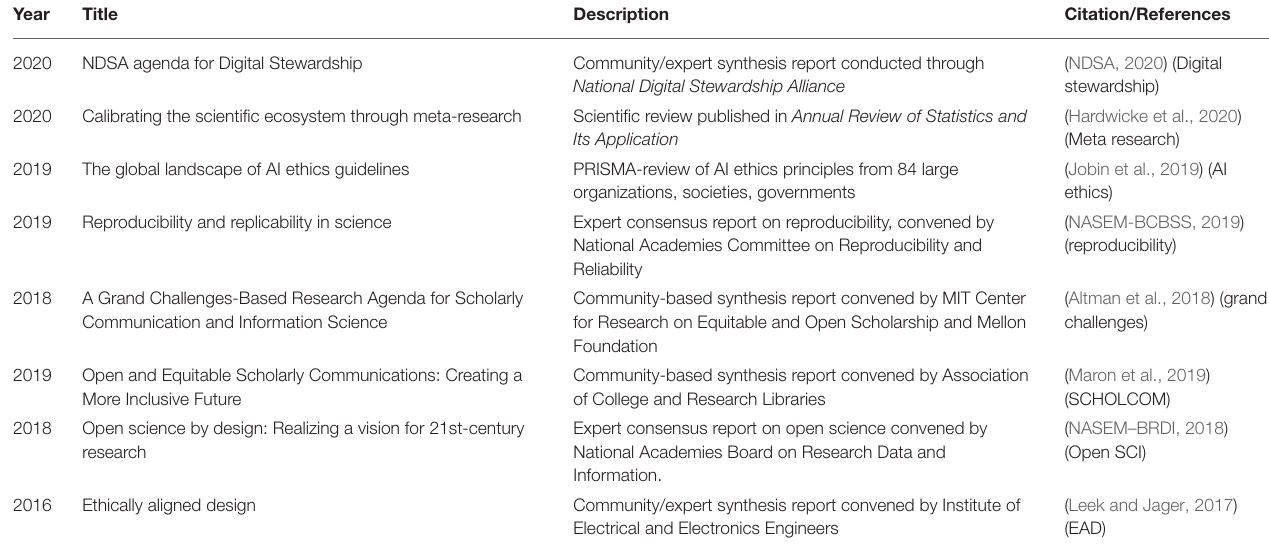
TABLE 1 | Key reports relevant to the scholarly knowledge ecosystem.